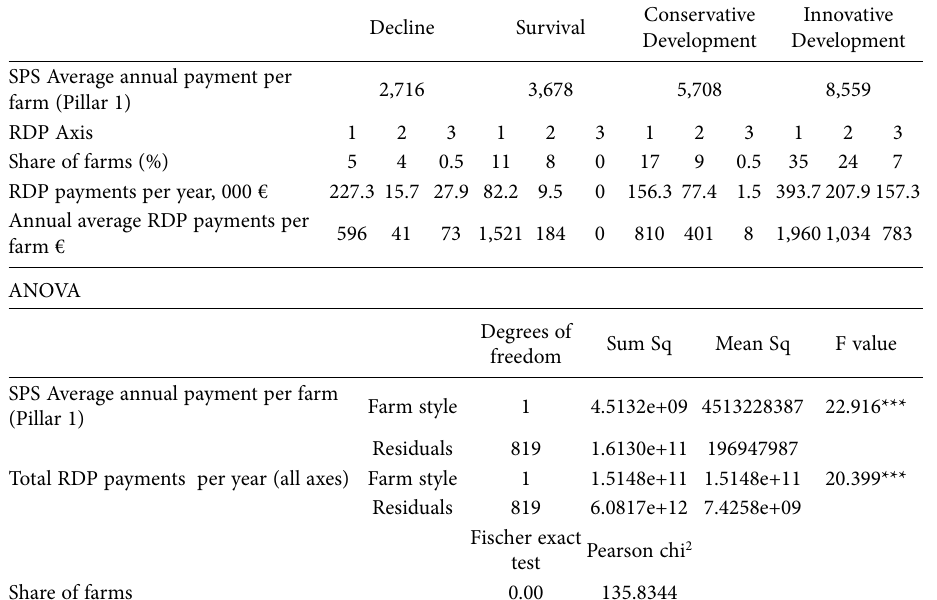
Table 13 . Mugello - First Pillar (SPS) and RDP payments according to the farming style.